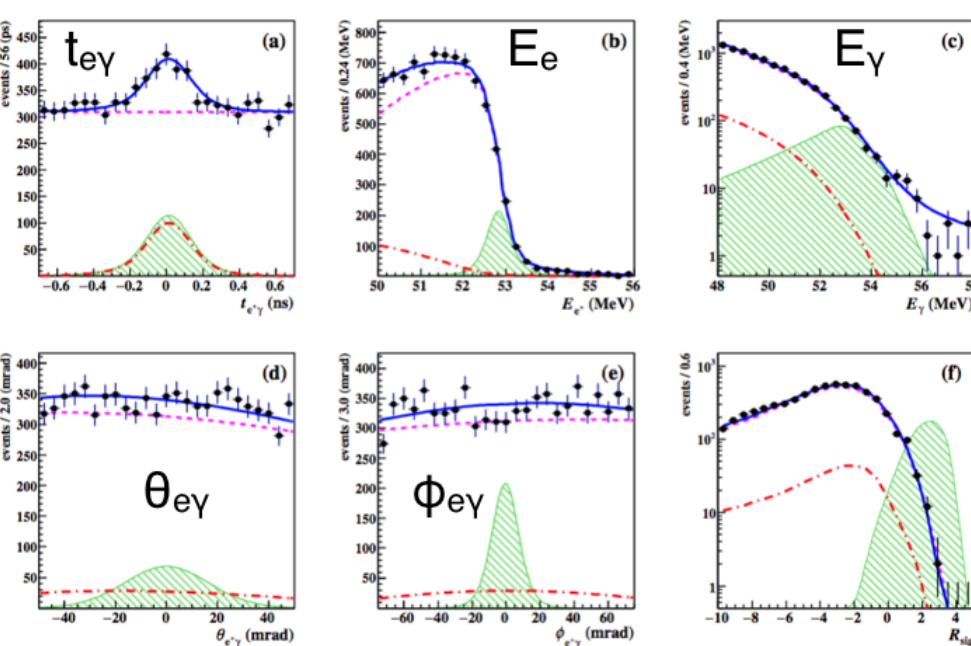
Figure 2: The best functions of each variable projected from the likelihood results for the full dataset, and the relative signal likelihood, R blue solid line is the total fit result, the magenta dash line is the number of accidental backgrounds, and the red dot-dash line is the number of